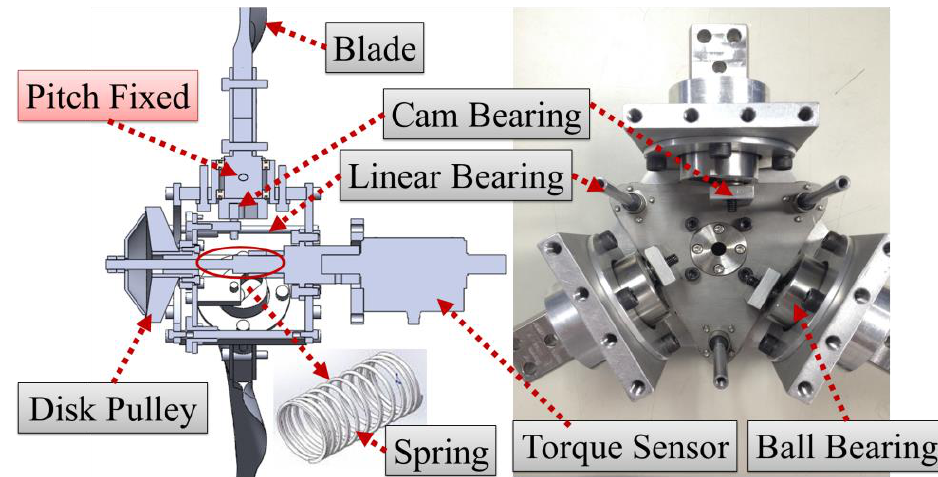
Figure 9. Components of the pitch control mechanism and the prototype.